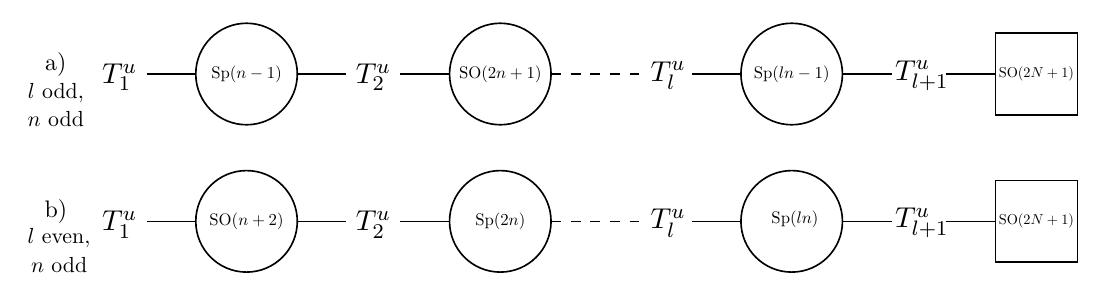
− 1 b) n is not trivial, but a half hyper. 1